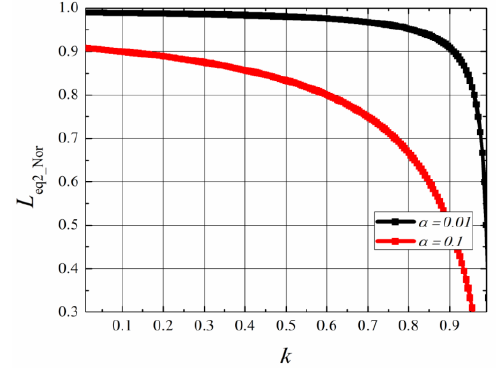
Figure 8. Sensitivity curves of L eq2,Nor to k and α . The inductor current waveform in each interval (Figure 6) shows that the inductor current is the largest in Interval 2; therefore, the equivalent inductance in Interval 2 ( L eq2 ) can be adopted as the design inductance ( L o_eff ), as illustrated in Equations (20) and (21).